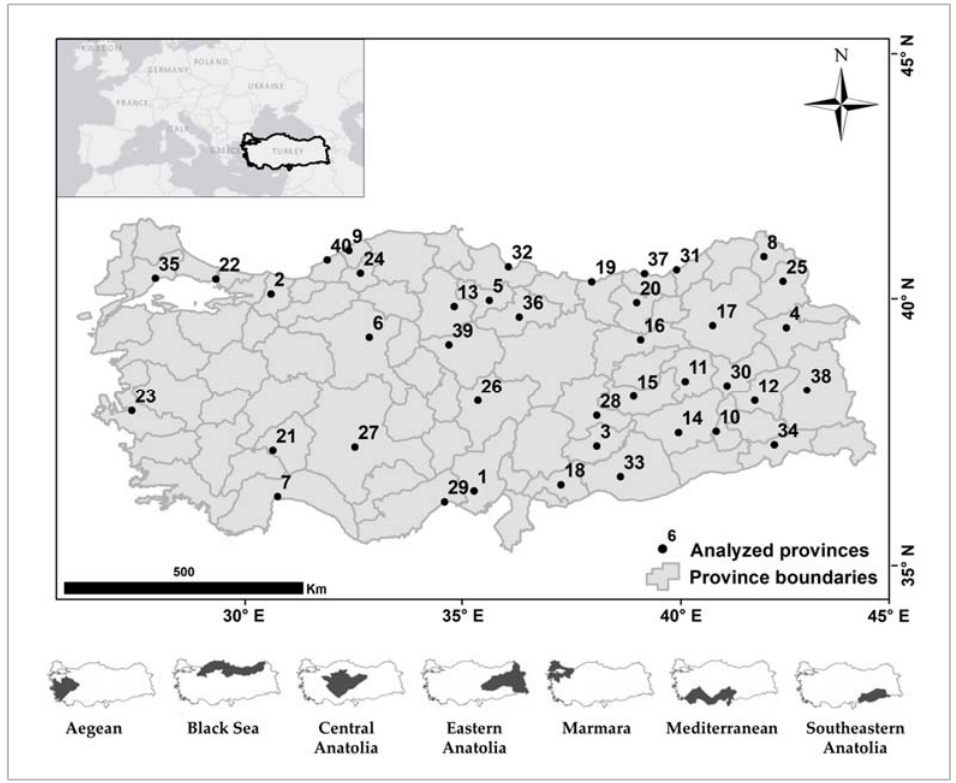
Figure 2. Site location map of the study area, analyzed provinces (numerated, please see the Appendix A, Figure A1 for province names), and geographic regions of Turkey (at the bottom).